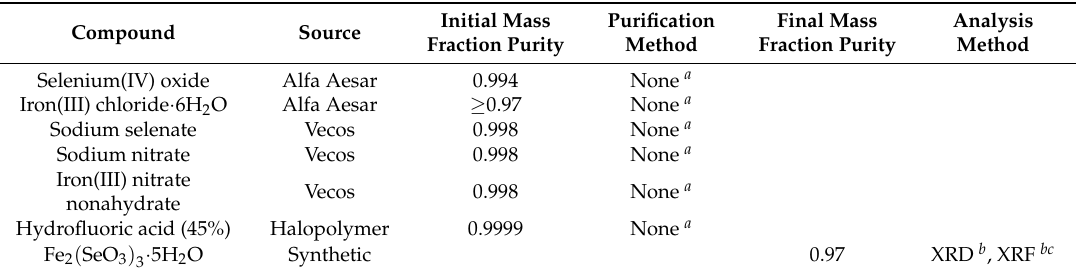
Table 1. Characterization of compounds used or synthesized in this